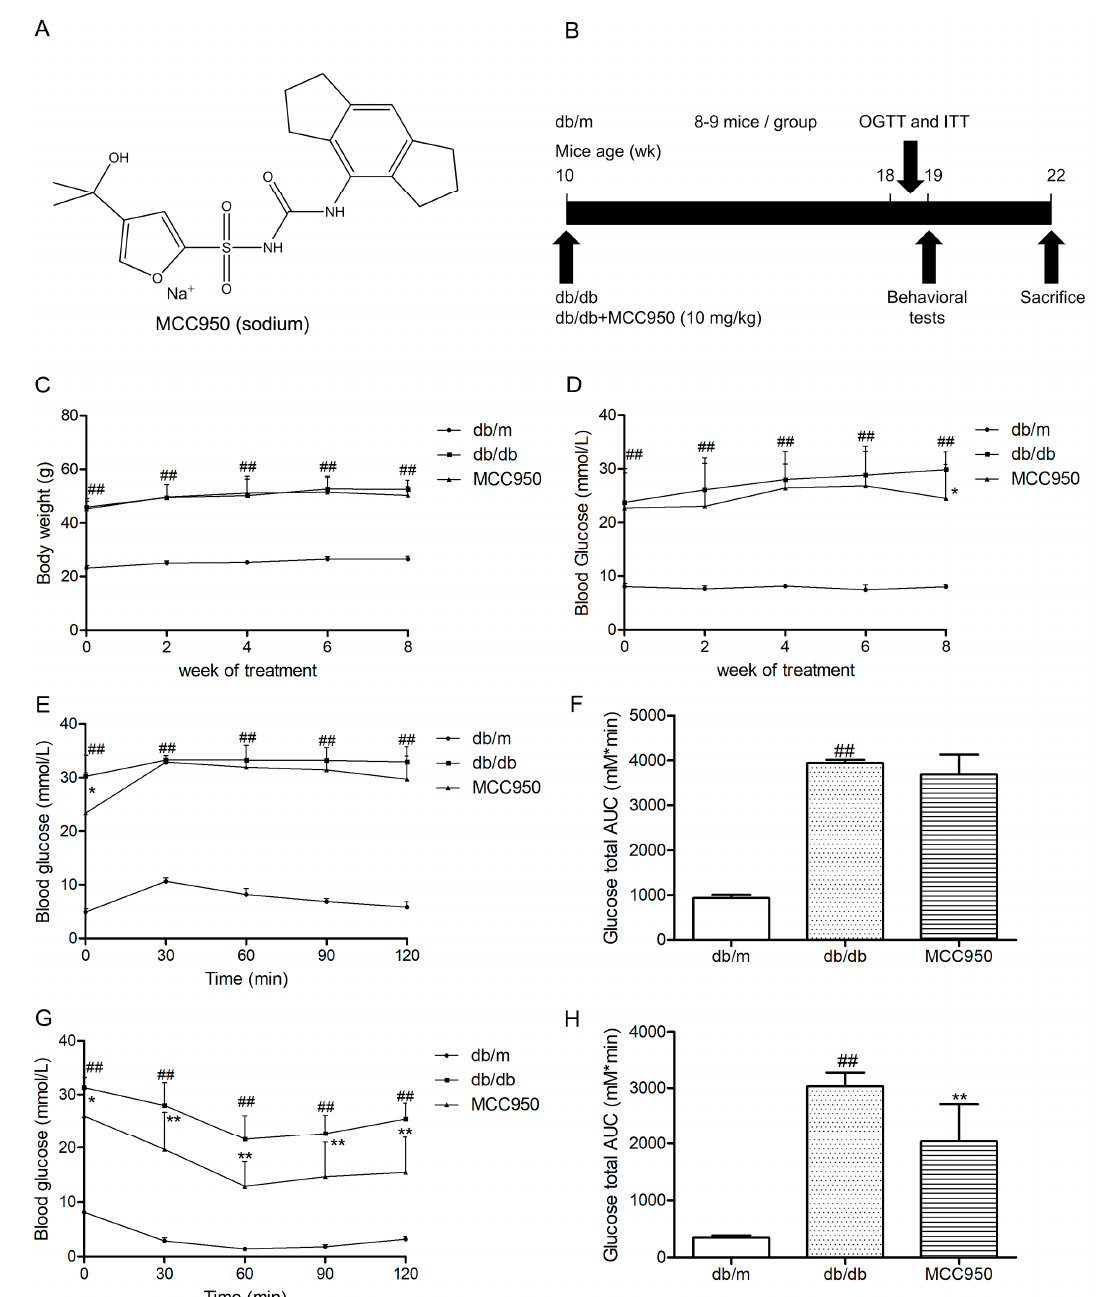
Figure 2. Effect of MCC950 on insulin resistance in db/db mice. ( A ) Chemical structure of MCC950 (sodium); ( B ) Schematic diagram showing the timeline scheme of the animal experiments in vivo; ( C ) Body weights in mice of each group during 8 weeks of treatment ( n = 8–9 mice/group); ( D ) Fasting blood glucose in mice of each group during 8 weeks of treatment ( n = 8–9 mice/group); ( E ) Curve of blood glucose levels in oral glucose tolerance tests (OGTTs; n = 8 mice/group); ( F ) Glucose total area under the curve (AUC) in OGTTs ( n = 8 mice/group); ( G ) Curve of blood glucose levels in insulin tolerance tests (ITTs; n = 8 mice/group); ( H ) Glucose total AUC in ITTs ( n = 8 mice/group). All data are represented as mean ± SD, ## p < 0.01, compared with the db/m-group; ** p < 0.01, * p < 0.05, compared with the db/db-group.